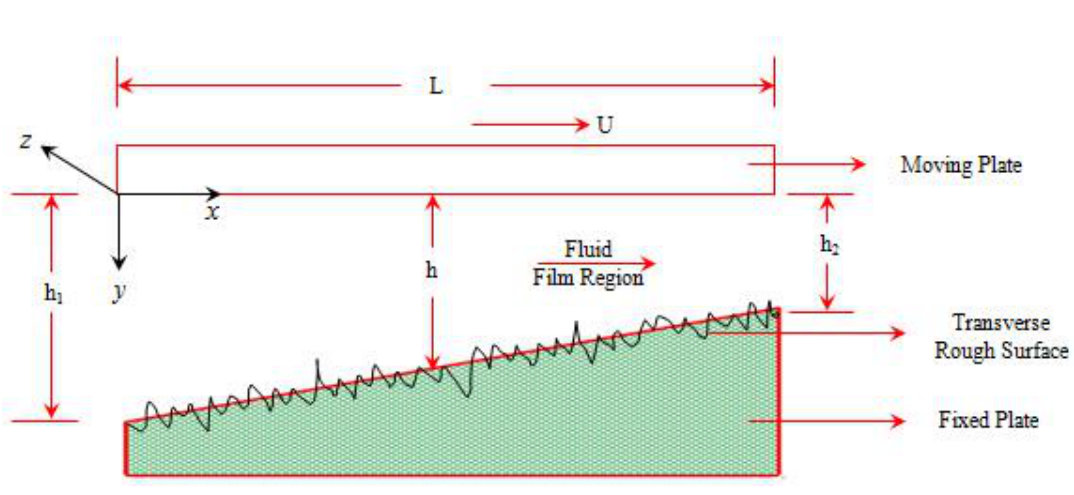
Figure 1. Configuration of the bearing system (Patel and Deheri,